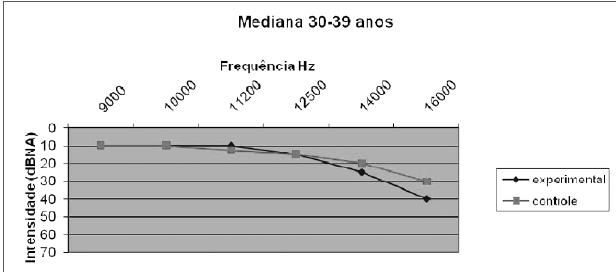
do teste estatístico ( p valor ) por faixa etária (30 a 39 anos e 40 a 49 anos), respectivamente.